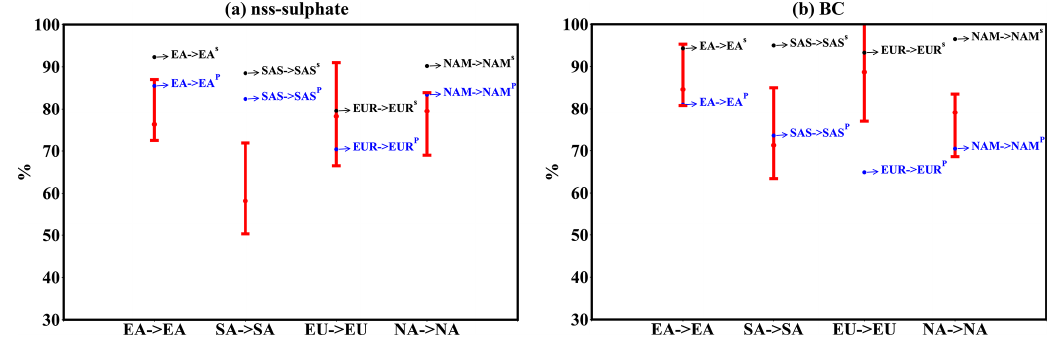
Figure 17. Contributions of (a) nss-sulfate and (b) BC in the surface layer and within the PBL from the HTAP report and GNAQPMS-SM. HTAP results with red error bars are based on the annual averages in 2001 from six global models. GNAQPMS-SM results in the surface layer are shown as black dots, and those within the PBL are shown as blue dots. (The region shown in the x axis of the horizontal coordinate is the result of HTAP division, which is slightly different from the region defined in this paper.) Table 3. Relative contributions (%) compared with those in the HTAP report (Dentener et al., 2010). The median and range of the annual averages of the six models are given